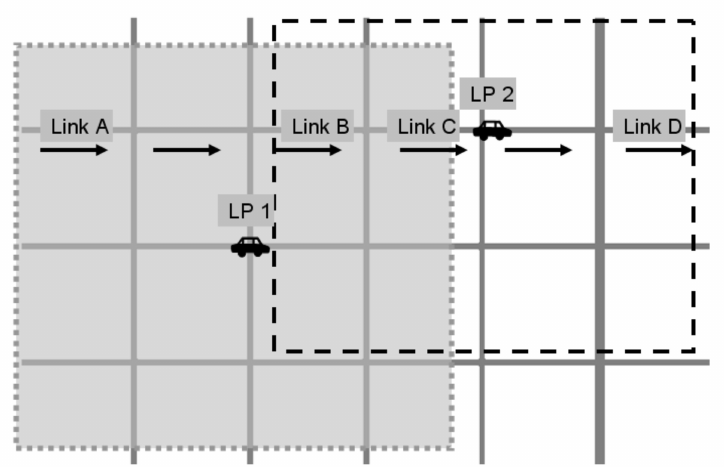
Figure 2. Two logical process